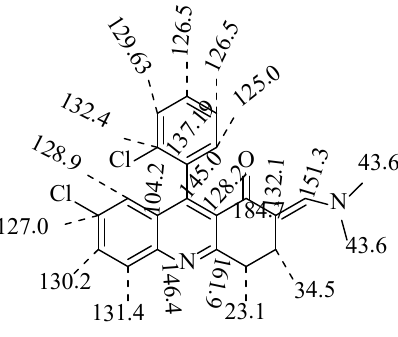
Figure 2: Summary of Carbon d Values of